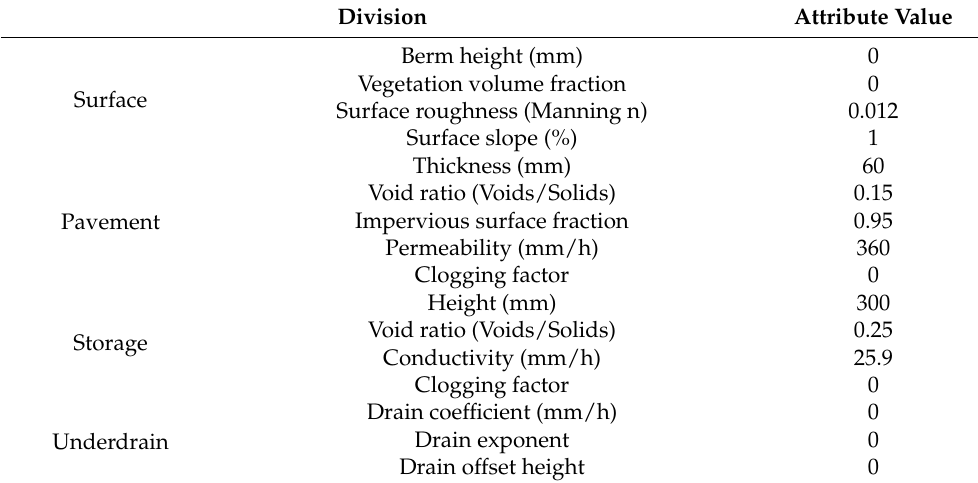
Table 3. Parameter values of permeable